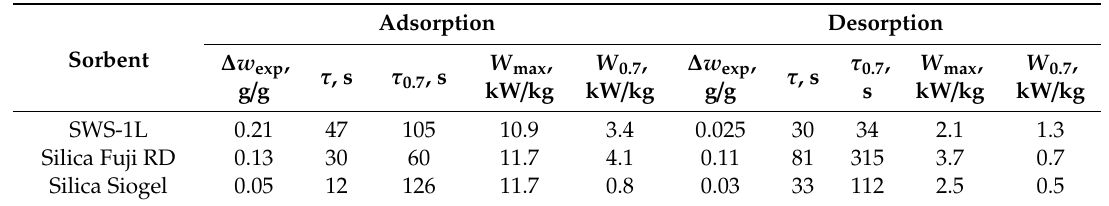
exponential approximation (3). Table 8. Results of the dynamic